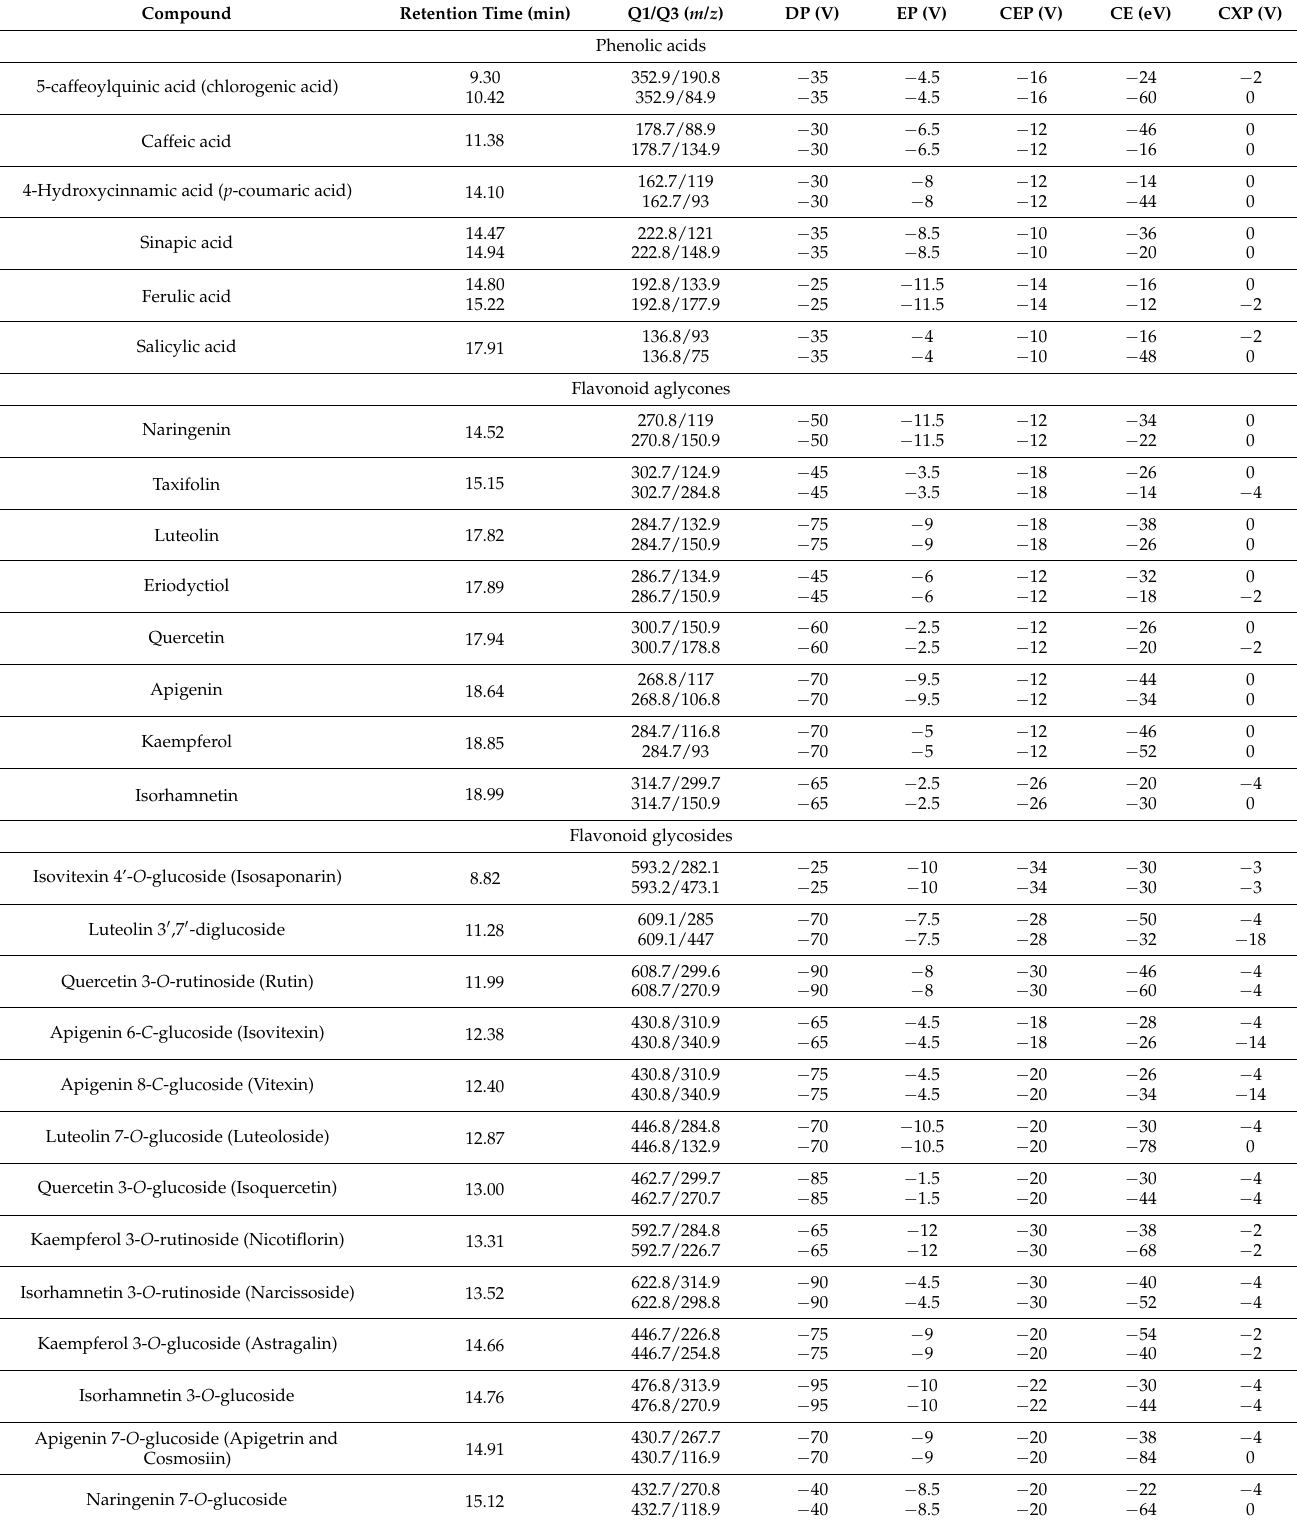
Table 8. LC-ESI-MS/MS analytical results of the phenolic acids and